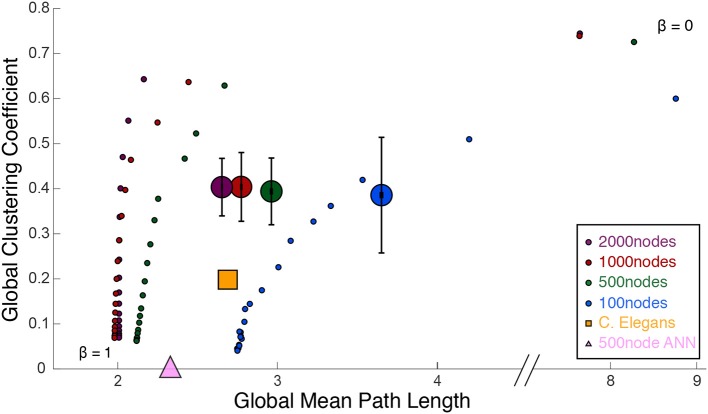
Watts and Strogatz (1998) cartographic plane: global clustering coefficient and global mean path length. Each large dot represents 39 ASNs of varying parameters, with colors representing the network size (number of nanowire nodes). The small dots are Watts-Strogatz networks, rewired from completely random (β = 1) to grid-like (β = 0). Beta values decrease from bottom to top. The large yellow square measures the C. elegans network, and the large pink triangle is a 500-node fully-connected ANN.